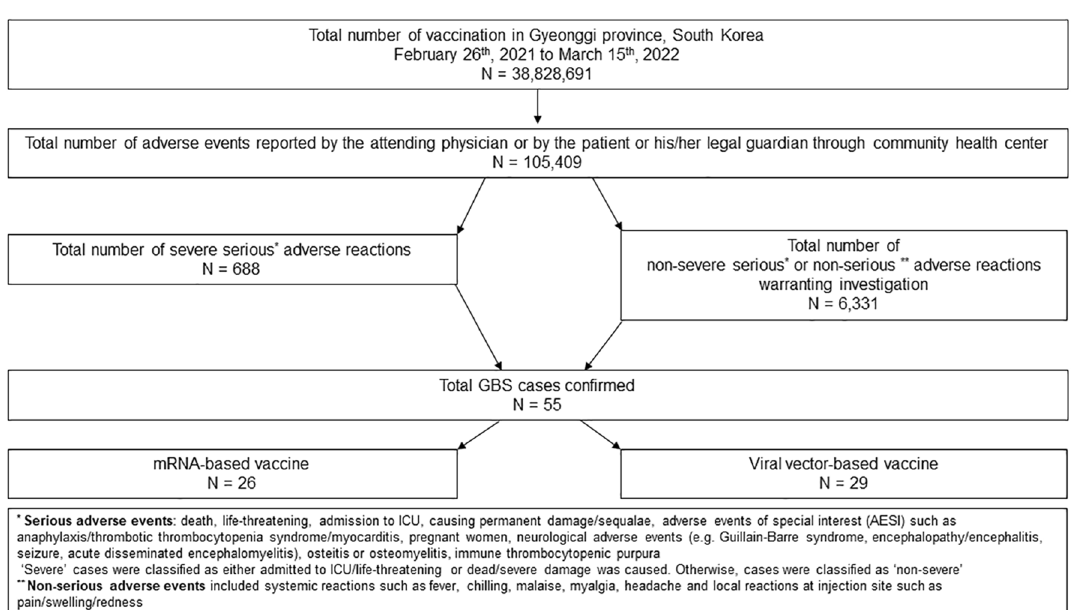
Figure 2. Flow diagram of study